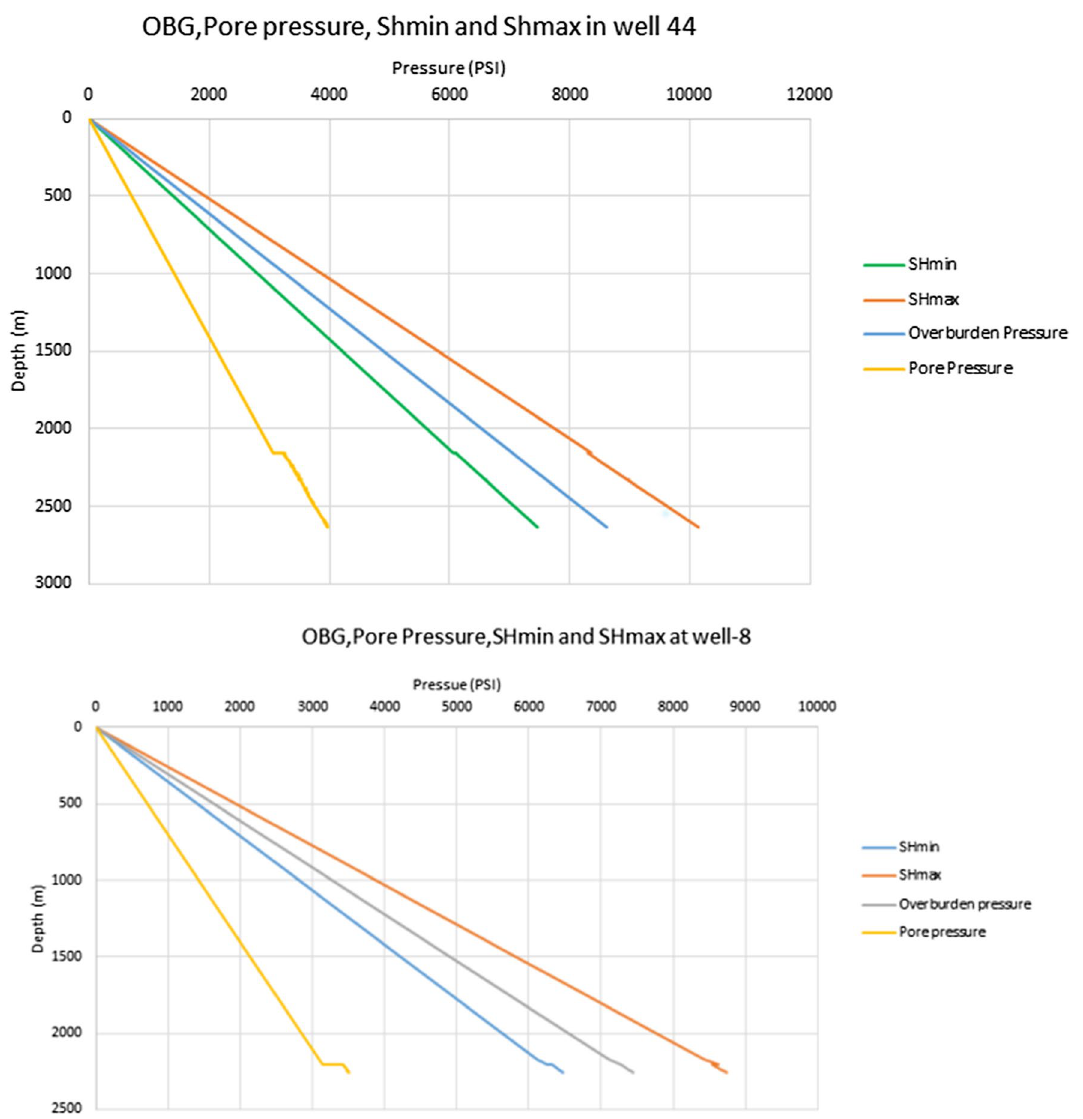
Fig. 8 Pore pressure (yellow graph), vertical stress (blue graph), minimum horizontal stress (green graph) and maximum horizontal stress (red graph) at well no. 44 and well no.